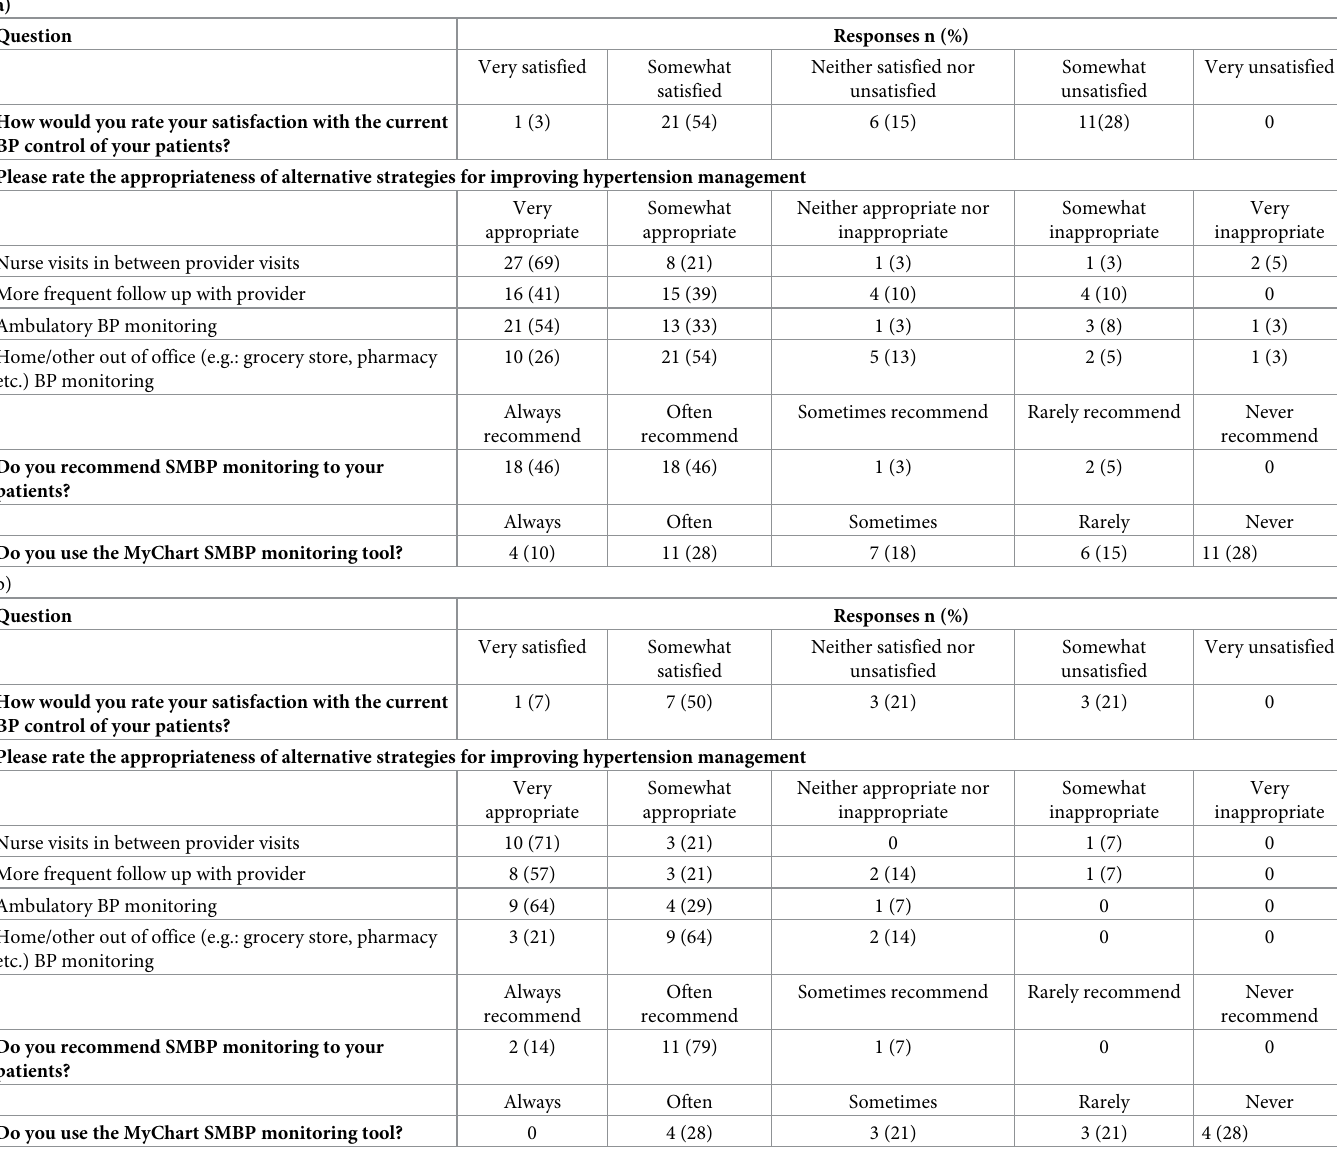
Table 1. Results of the survey on hypertension management a) from the 39 primary care physicians initially approached and b) from 14 primary care physicians who completed the